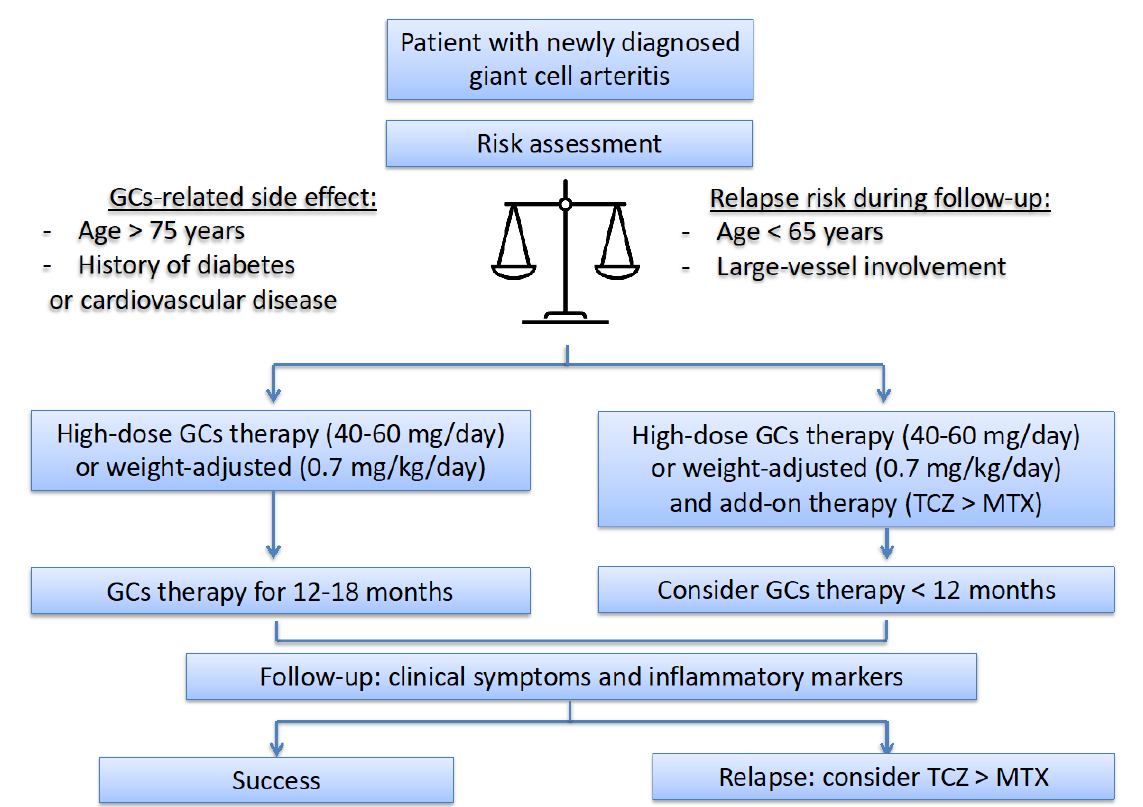
Figure 1. Proposed algorithm for treating giant cell arteritis. GCs: glucocorticoids; MTX: methotrexate; TCZ: tocilizumab.